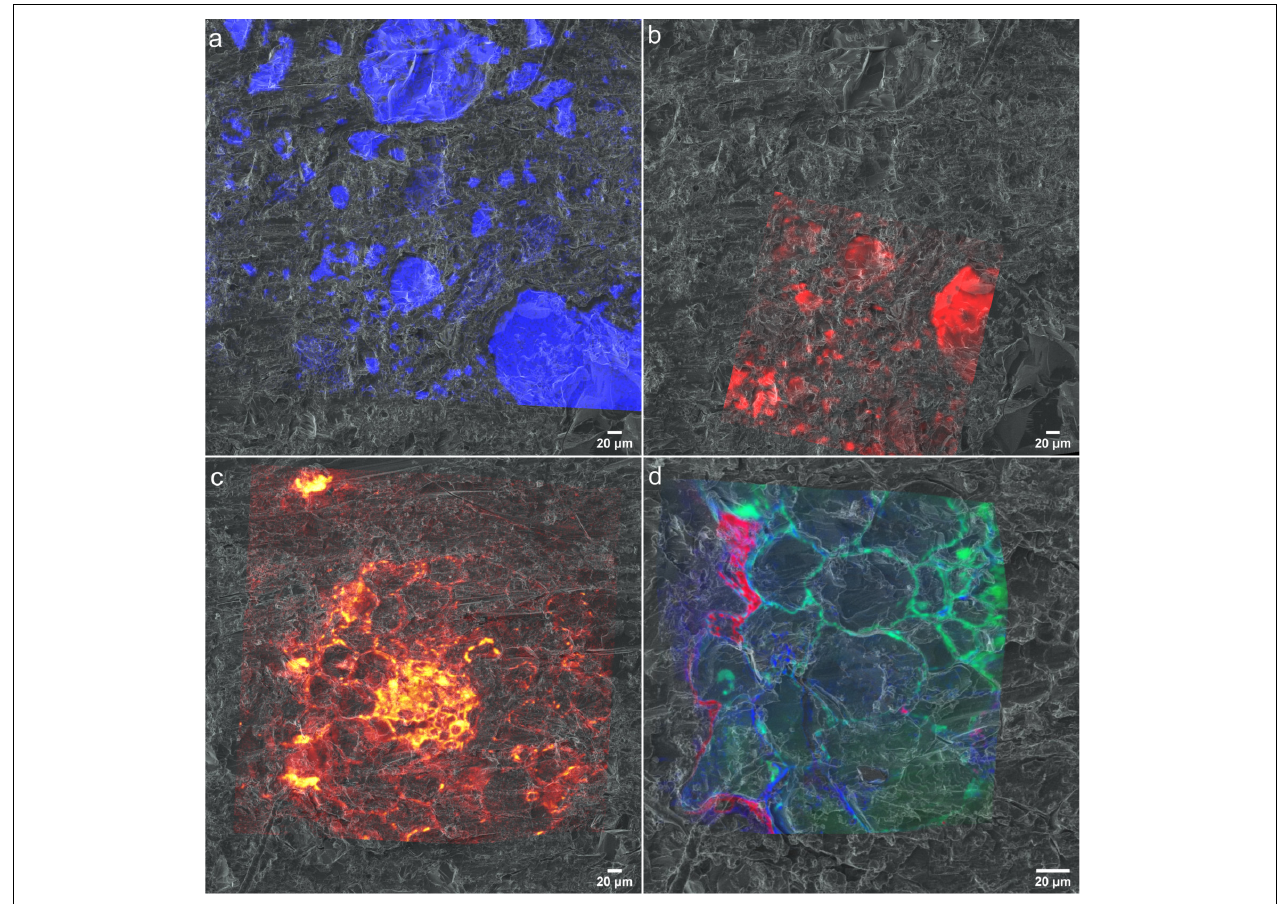
FIGURE 9 | Chemical maps registered to helium ion micrographs (a) EDX spectra of Si registered onto HIM (b) Raman spectra resisted on to HIM (c) CNO − spectra of ToF-SIMS registered onto HIM. (d) 12 C 14 N − , 31 P − and 32 S − distribution maps from nanoSIMS registered onto HIM.